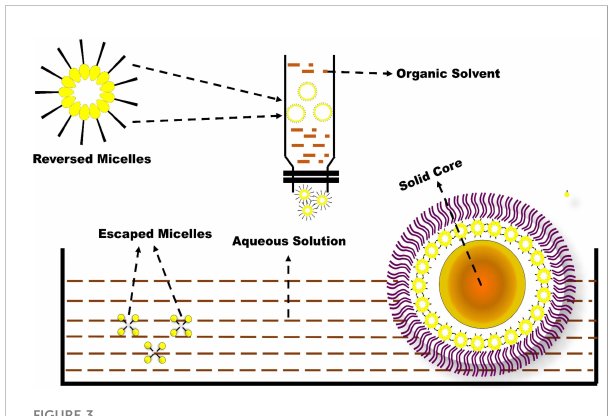
FIGURE 3 Mechanism and Formation of Micelles while formulating DTIC-SLNs.